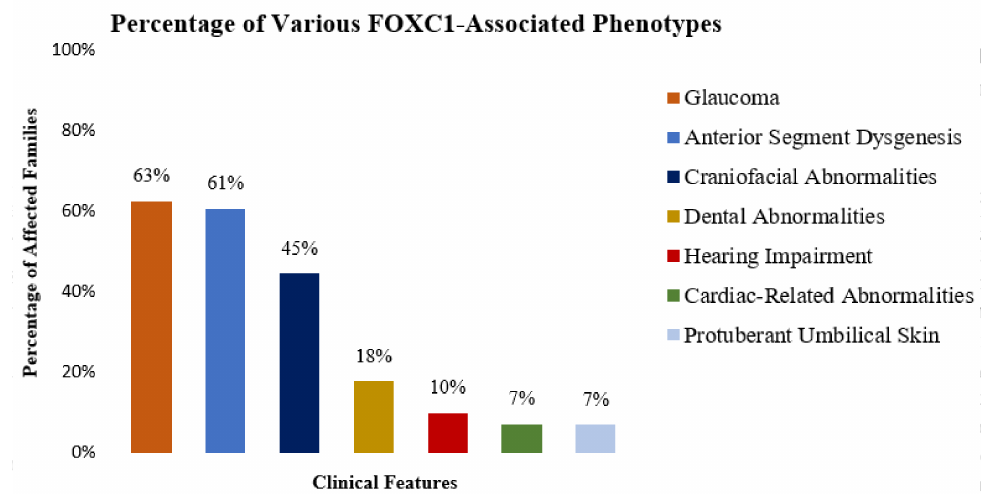
Figure 3. Prevalence of the commonly occurring clinical features among 56 individuals from 12 fami- lies affected with truncating variants of FOXC1 from Table 1 ( n = 56